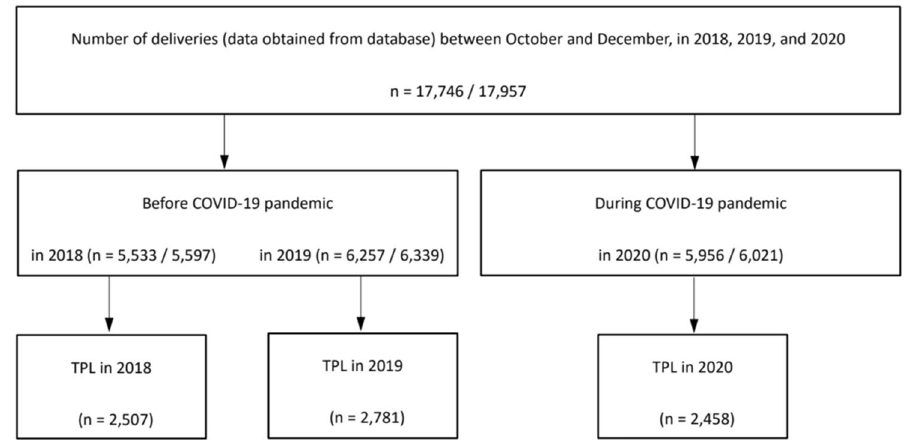
Figure 1. Flow chart of the study population. We firstly extracted delivery information from October to December between 2018 and 2020 from the database. The numbers of participants were shown based on deliveries and newborns. We defined the deliveries in 2018 and 2019 as before the COVID-19 pandemic and the deliveries in 2020 as during the COVID-19 pandemic. TPL was diagnosed by ICD-10 code and the use of tocolytic agents, which records were used to analyze each medical use and dosage. COVID-19 Coronavirus disease 2019, TPL threatened preterm labor.